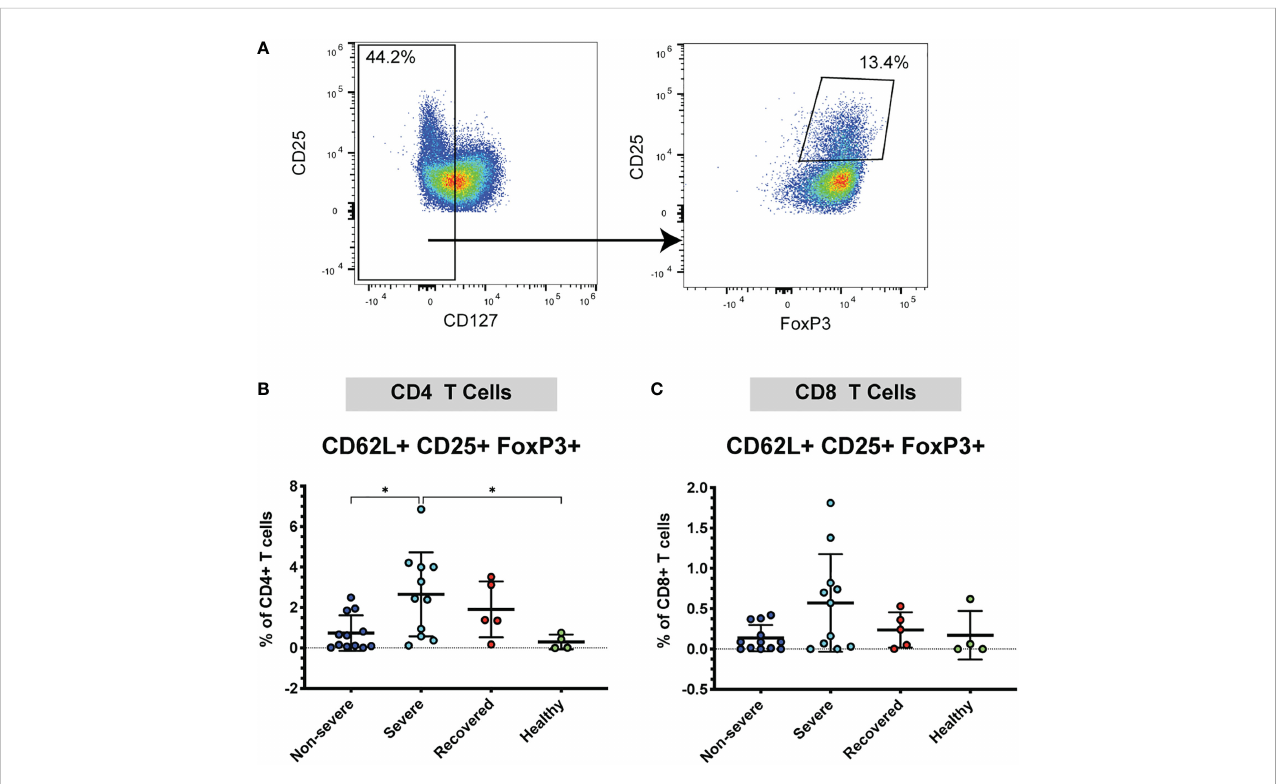
FIGURE 2 Severe COVID-19 patients have more CD4+ CD62L+ Tregs. The frequencies of CD4+ and CD8+ Tregs (viable, CD14- CD56-, CD19-, CD3+, CD4+ or CD8+, CD127lo, CD25+ FoxP3+) in non-severe and severe COVID-19 patients, recovered COVID-19 patients, and healthy controls were assessed by fl ow cytometry. (A) Example fl ow cytometry staining showing CD4+ CD62L+ T cells being gated on CD127lo, followed by gating for CD25+ FoxP3+ to identify Tregs. (B) CD4+ CD62L+ Tregs; (C) CD8+ CD62L+ Tregs. *p<0.05 one way ANOVA with multiple comparisons